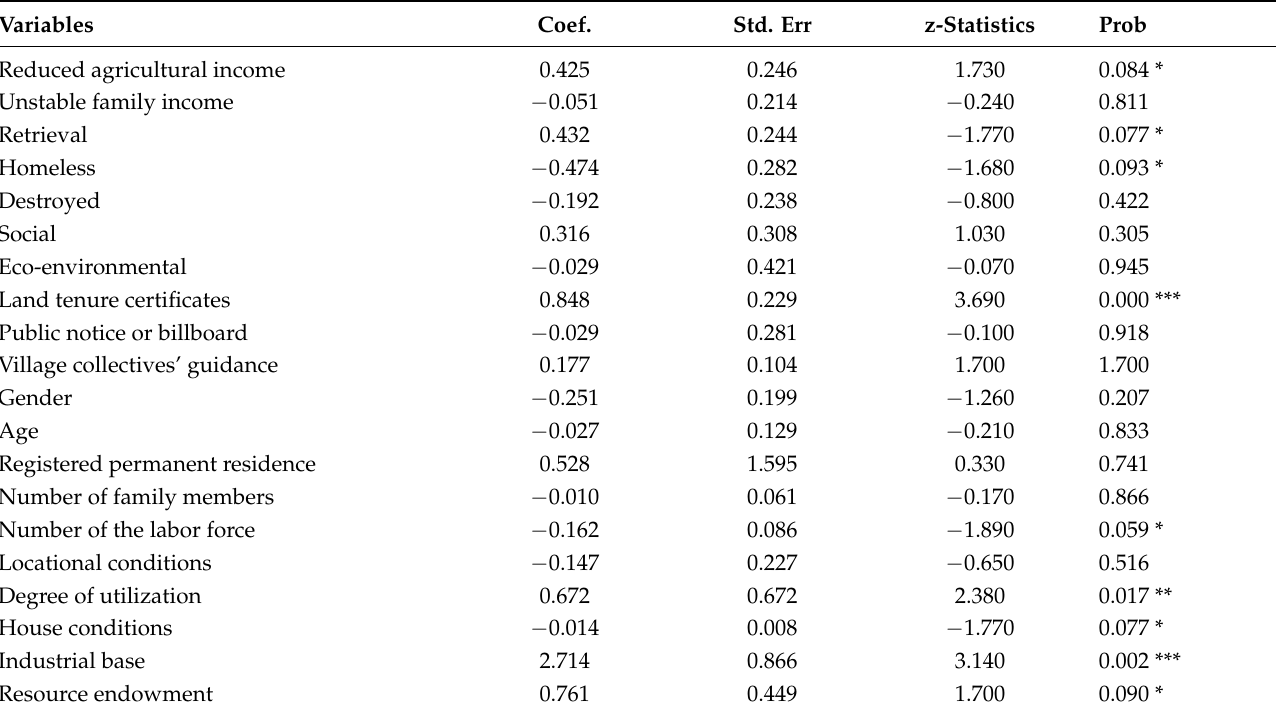
Table 7. Regression results excluding extreme